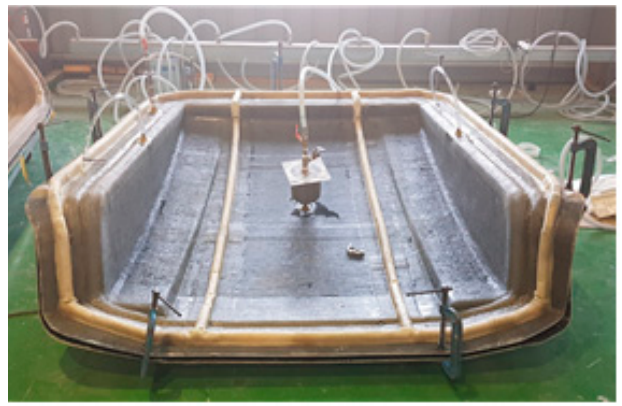
Figure 14. The resin transfer process.